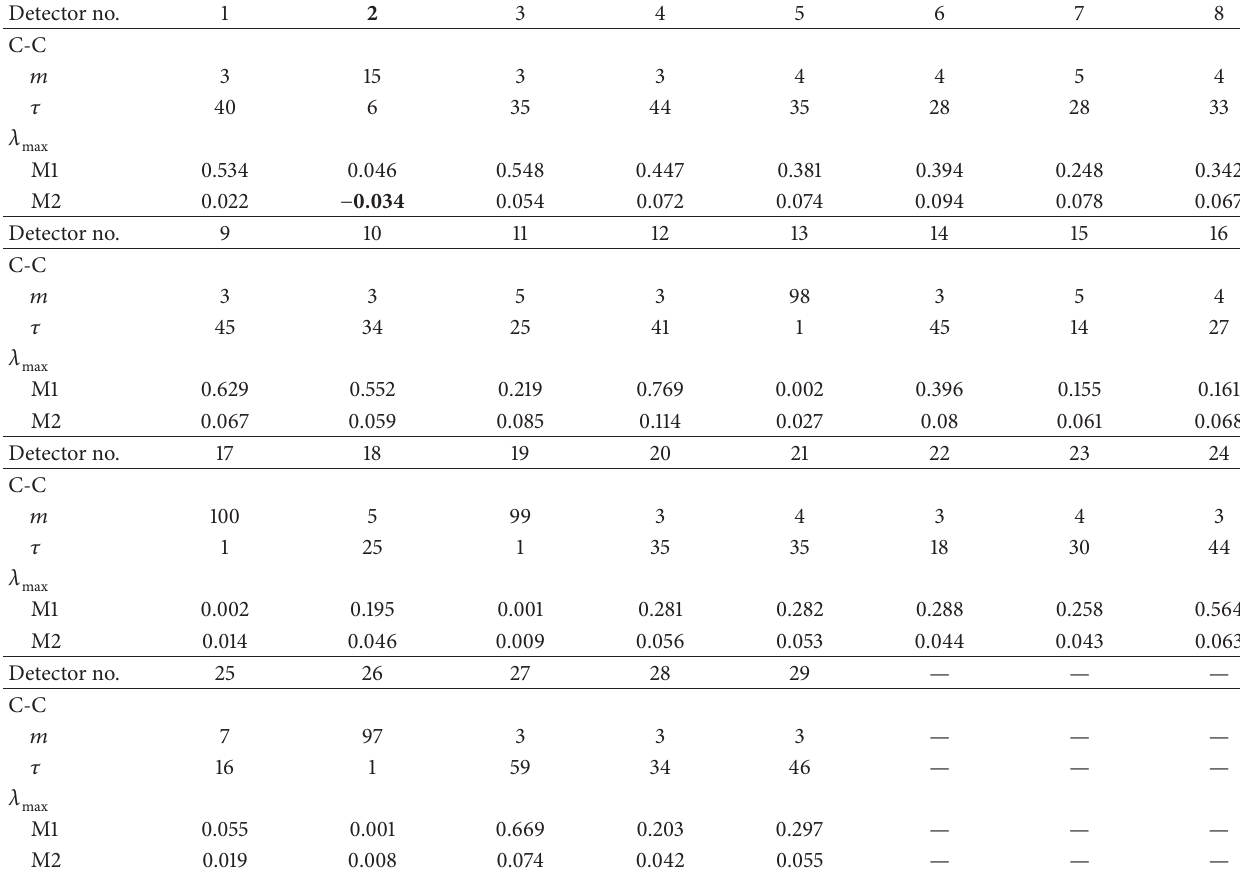
Table 5: C-C method result and Lyapunov exponents for